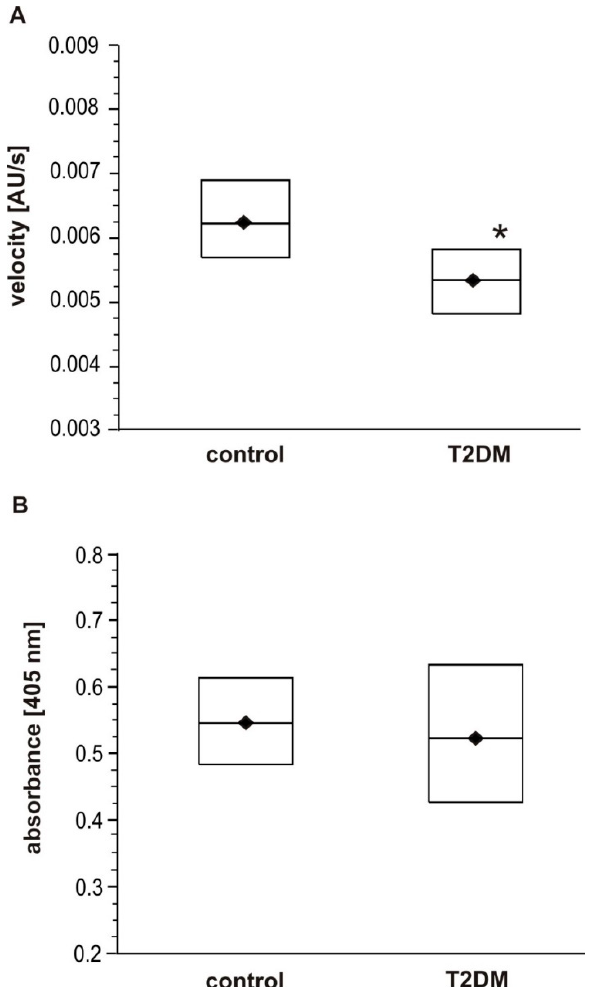
Figure 2. Fibrin polymerization in plasma from control subjects and T2DM patients: ( A ) maximal velocity (V max ); ( B ) absorbance change (F max ). Data shown as median (horizontal bar) and lower-upper quartile range (box); n = 24 for DM, n = 20 for control. The clot formation rate is represented by two variables: the maximal velocity (V max ) ( A ) and the change in the absorbance (F max ) calculated as a di ff erence between absorbance maximum and baseline ( B ). Significance of di ff erences estimated with the bootstrap-boosted Mann–Whitney U test. The V max appeared significantly lower in T2DM patients (* p < 0.05). The absorbance change (F max ) did not di ff er significantly between